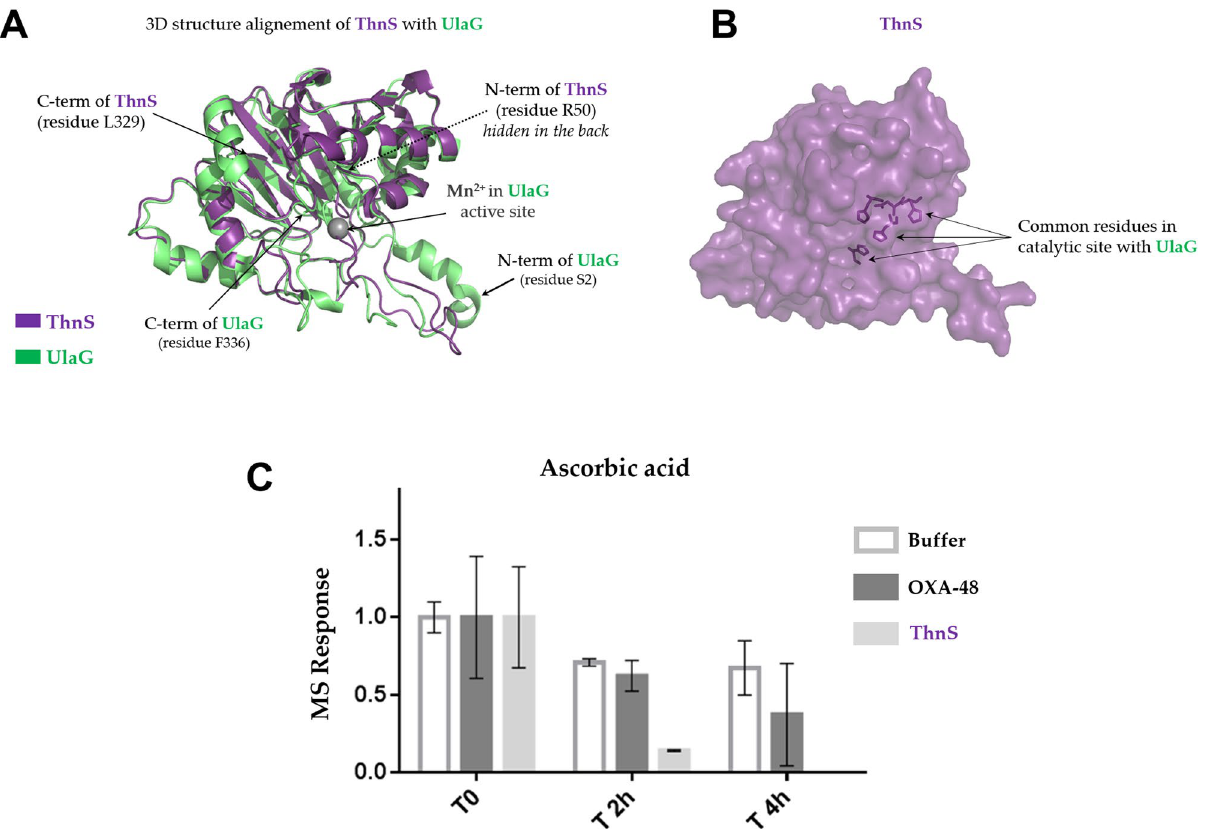
Figure 4. 3D model of the ThnS enzyme and monitoring ascorbic acid degradation by ThnS. ( A ) 3D structure comparison of the ThnS Phyre2 model and the UlaG structure (PDB: 2WYM); ( B ) 3D model of ThnS showing common residues in the catalytic site with the UlaG enzyme; structure alignment and visualisation were performed using the PyMOL 1.8.6.0 software (https:// github. com/ schro dinger/ pymol- open- source). ( C